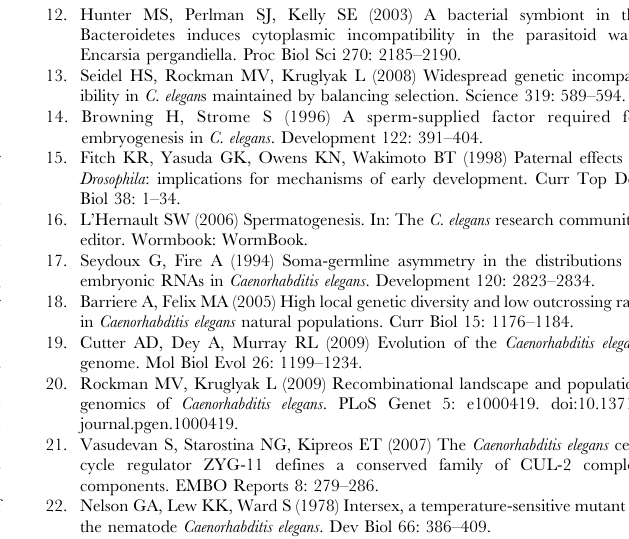
Figure S9 Cell-specific killing via ectopic expression of peel-1 .